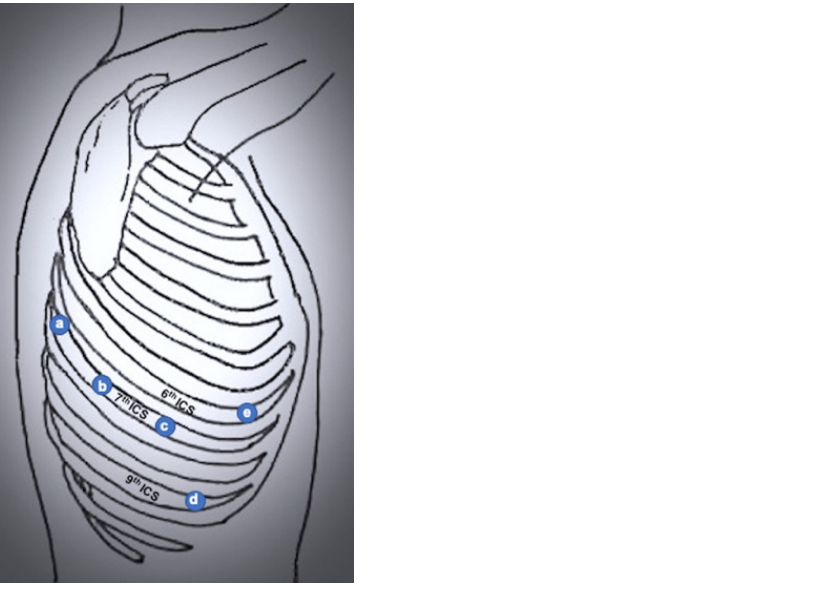
Figure 5. Port mapping of 4-port completely portal robotic lobectomy. ( a ) Robotic left arm 1 (lung retraction); ( b ) robotic left arm 2; ( c ) camera port; ( d ) assistant port; ( e ) robotic right